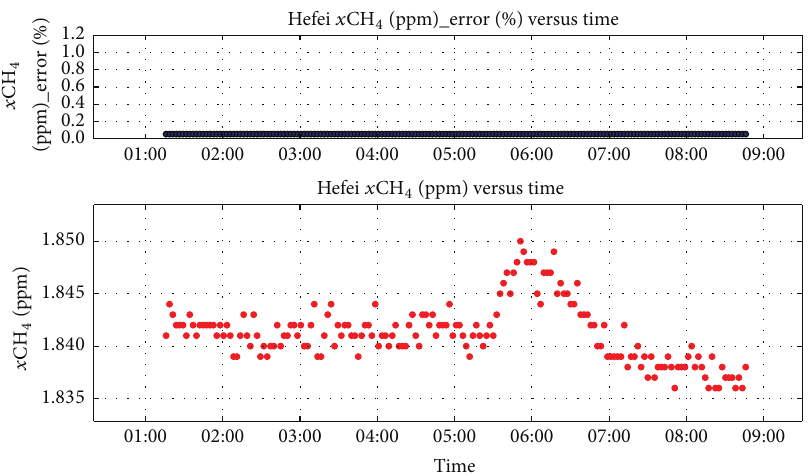
Figure 11: DMF time series on October 24, 2014, which are calculated according to VCD CH 4